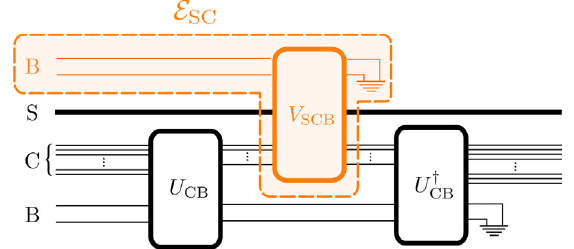
FIG. 1. Main protocol. The catalyst C is processed using the unitary U , and then, along with the system S, it is used as an CB ( ð · Þ ⊗ τ ) V † V input for the operation E · Þ ≔ Tr (cid:2) . SC ð B ½ SCB B SC SCB The resulting state of the catalyst is then transformed back using . As long as the backaction of the map E on the the unitary U † SC CB catalyst is small, the protocol as a whole leaves the state of the catalyst approximately